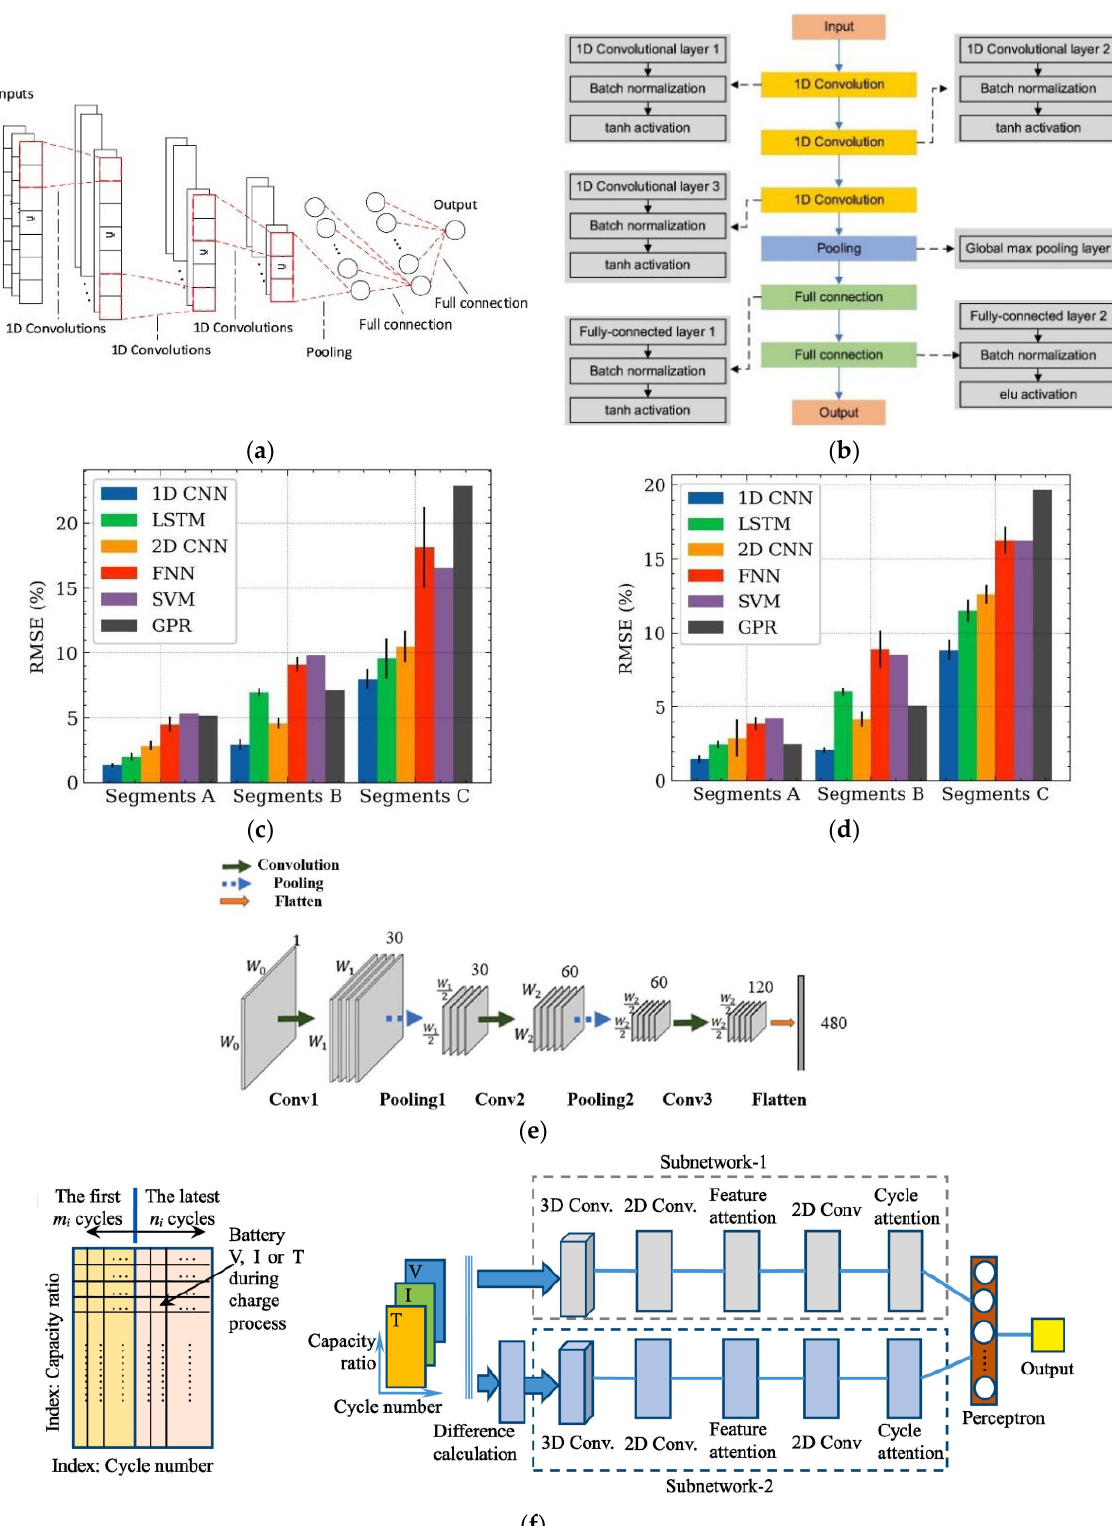
Figure 11. ( a ) The basic process of CNN; ( b ) CNN architecture based on 1D convolution; ( c ) Com- parison of RMSE between DCNN and control experiments 1; ( d ) Comparison of RMSE between DCNN and control experiment 2; ( e ) Ren Lei’s CNN Algorithm Structure; ( f ) Yang Yixin’s CNN Algorithm Structure.